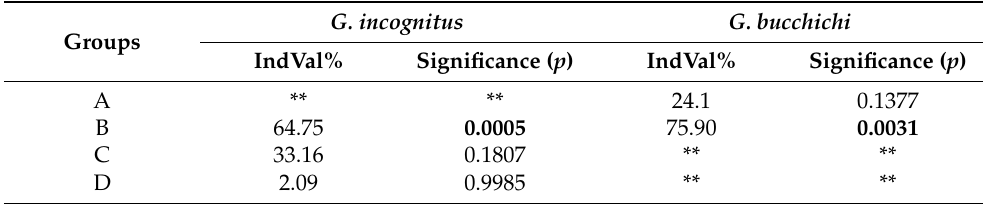
Table 3. Indicator species (IndVal) index values of G. incognitus and G. bucchichi (statistically signifi- cant values at p < 0.05 indicated in bold). ** - not